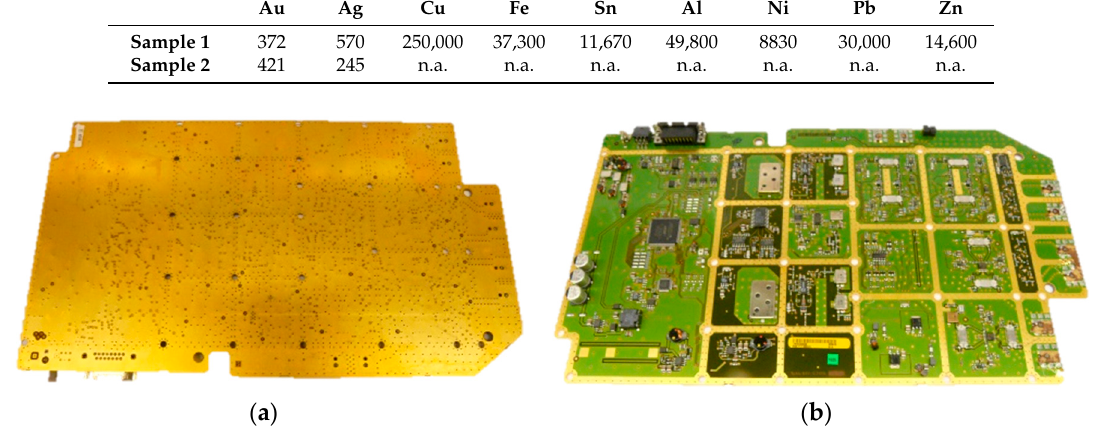
Figure 1. The WPCB raw material investigated: ( a ) the gold-coated side; ( b ) the side where larger electronic components have been removed.